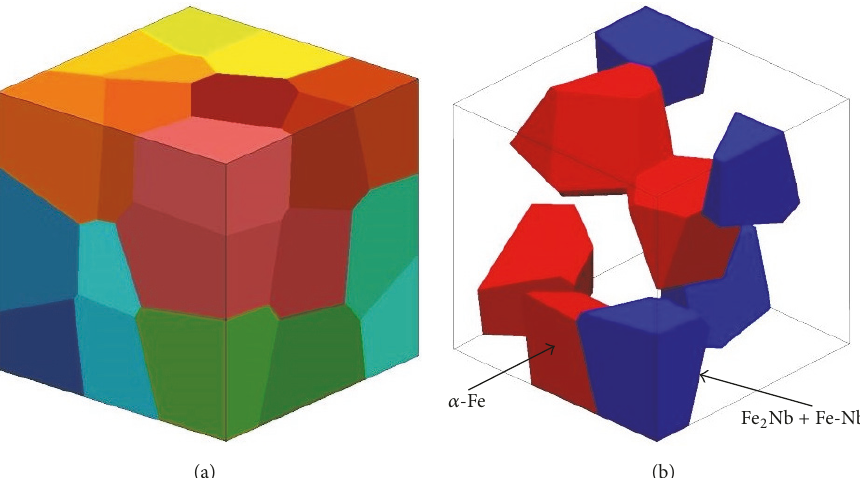
Figure 2: (a) Micromagnetic finite element model structure with 29 directly coupled Voronoi grains and (b) four 𝛼 -Fe grains (red) and four Fe-Nb-B grains (blue).